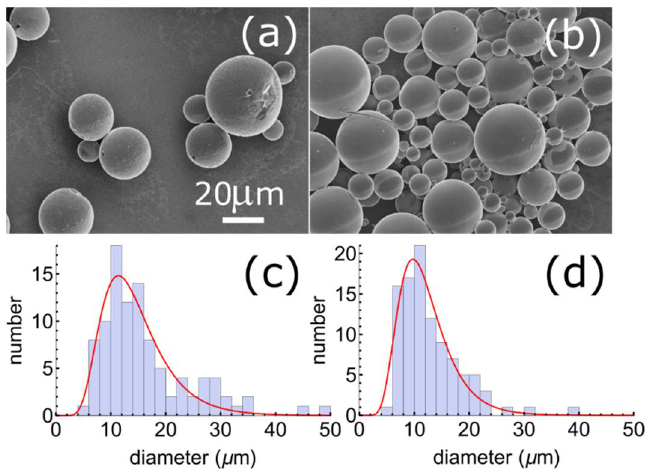
Figure 2. Secondary electron helium ion micrographs of MEH-PPP ( a ) and MEH-PPV ( b ) micro- spheres. The corresponding size distributions for MEH-PPP ( c ) and MEH-PPV ( d ) microspheres, along with a lognormal fit.